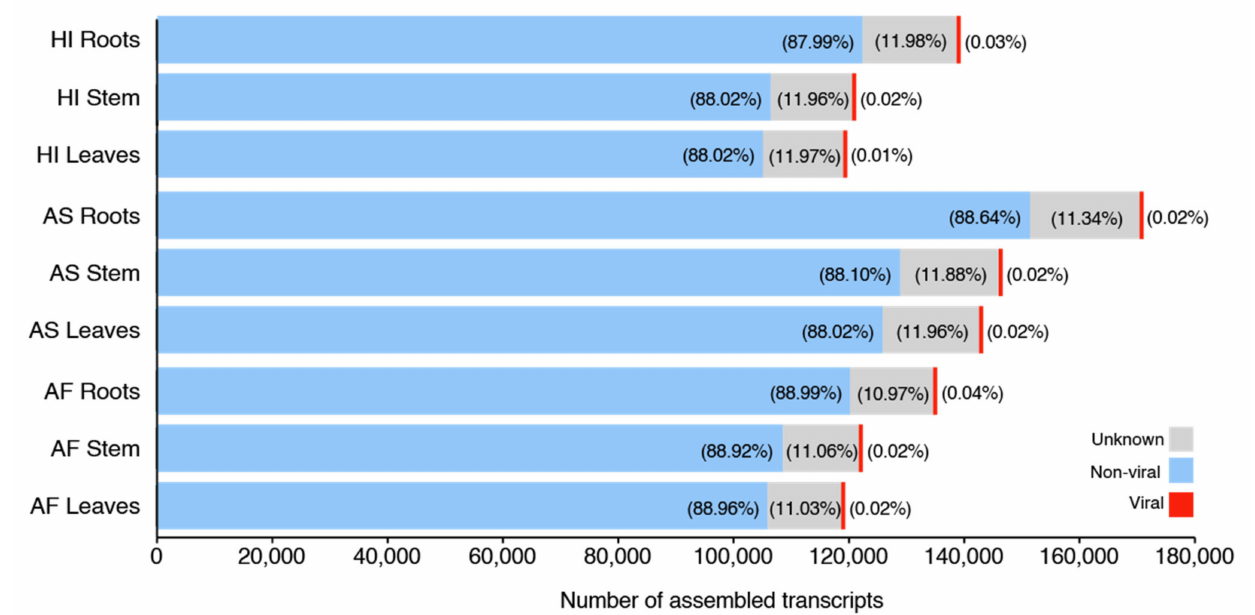
Figure 2. Overview of sequence similarity searches. The bar plots indicate the non-normalized values of viral, unknown, and other (non-viral) contigs in the nine analyzed samples. Color keys are indicated in the figure. Percentages are indicated inside color bars or on the right side, for viral contigs values. “Unknown” represents sequences with no significant hit at NCBI nucleotide and protein databases, while “non-viral” indicates sequences with hits with any other organism but